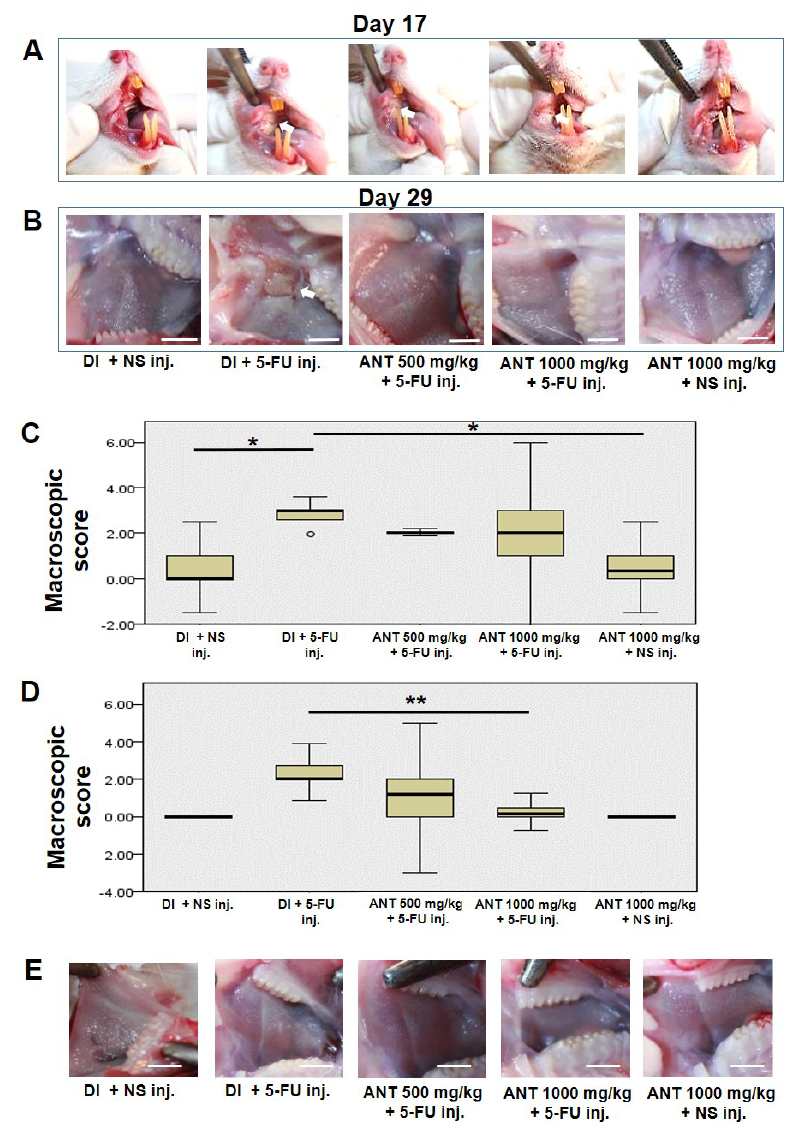
Figure 3. Pretreatment of rats with ANT-rich extract attenuates 5-FU-induced oral mucositis lesion. Rats were gavage-fed with either deionized water (DI) or ANT-rich extract and injected with normal saline (NS) or 5-FU. Macroscopic analysis of the oral mucositis lesion at the right buccal mucosa was observed on ( A ) day 17 and ( B ) day 29. Arrows indicate oral mucositis lesion. Scale bar, 10 mm; the box plots of the macroscopic scores of the mucositis lesion on ( C ) days 17 and ( D ) days 29 were measured by three examiners. Data are expressed as mean ± S.D., n = 6, Kruskall–Wallis test, * p < 0.001, ** p < 0.01. Box plots represent the median levels and the 25th and 75th percentiles of the observed data; whiskers represent the 5th and 95th percentiles in each group, and outliers ( ◦ ); ( E ) macroscopic analysis of the left buccal pouch without mechanical trauma on day 29. Scale bar, 10 mm.